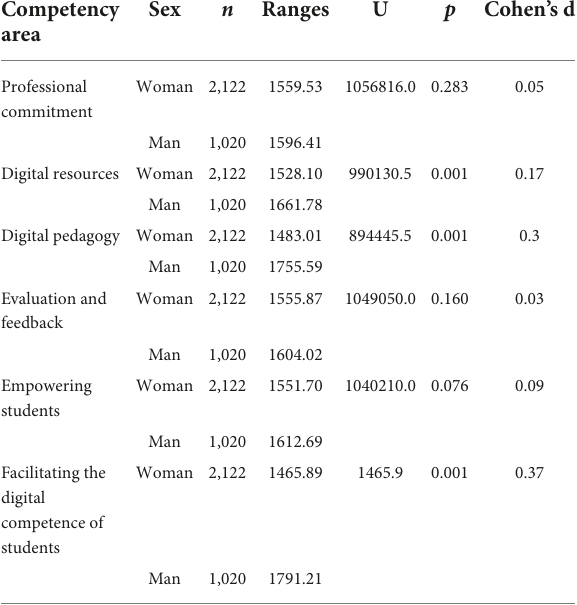
TABLE 3 Results of Mann-Whitney U for the areas of digital teaching competence with effect size by sex.